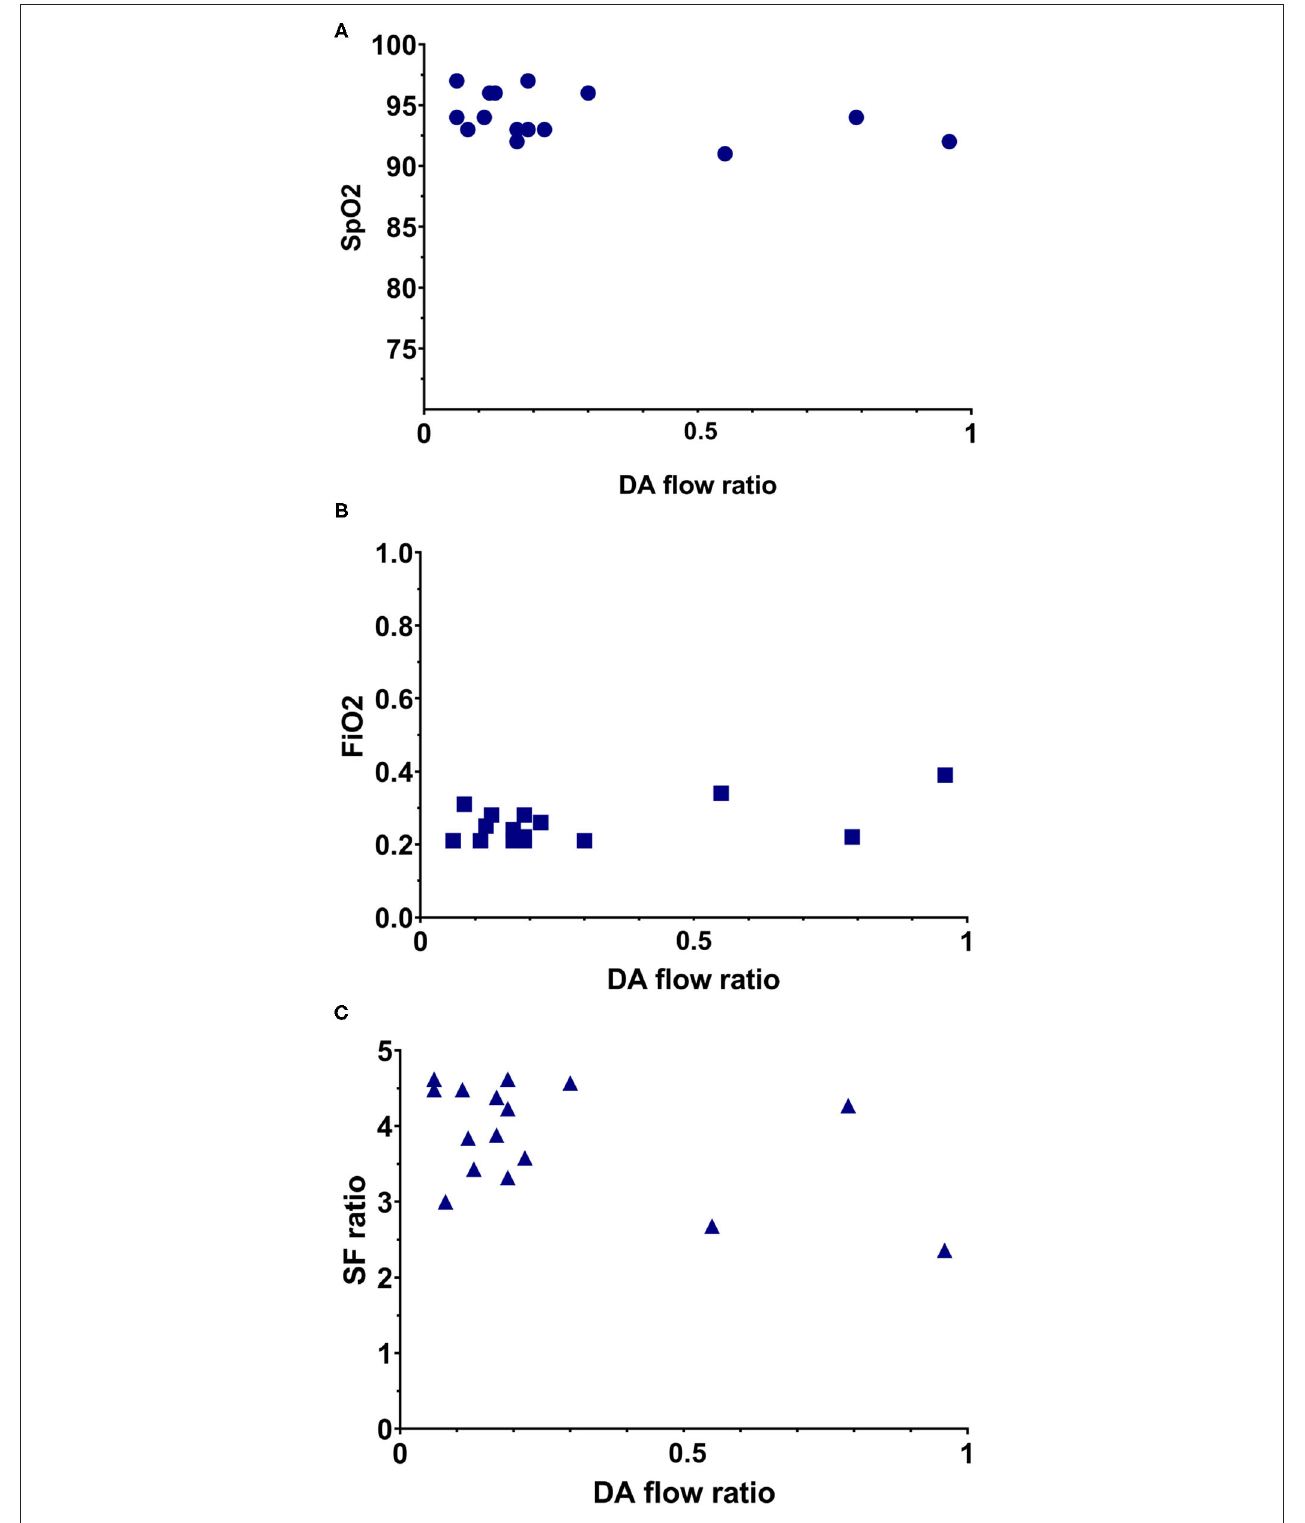
FIGURE 3 | Simple scatterplot of the relation between DA flow ratio with oxygenation parameters. (A) Relation between DA flow ratio and the SpO 2 . (B) Relation between DA flow ratio and FiO 2 . (C) Relation between DA flow ratio and SF ratio.